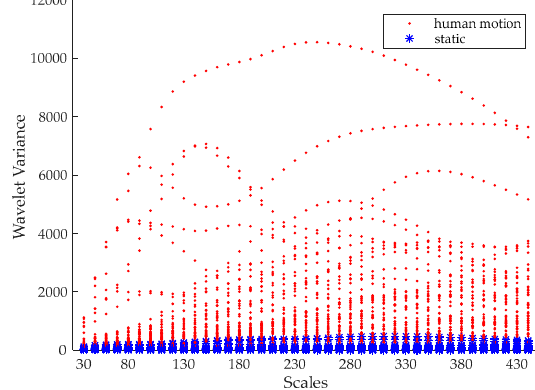
Figure 3. Wavelet coefficient of Channel State Information (CSI) when people move.